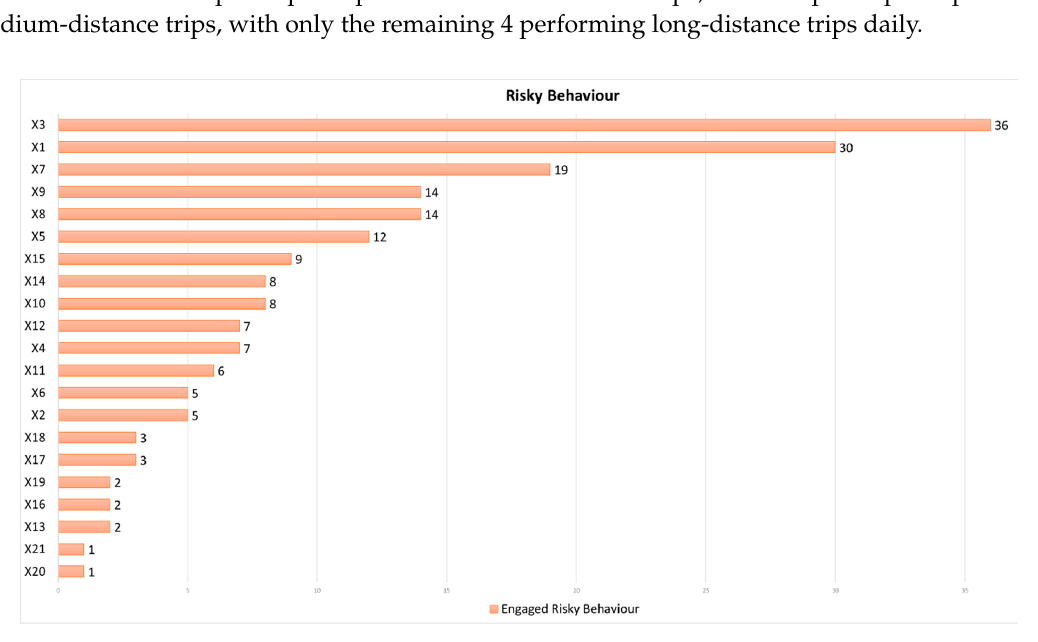
Figure 2. Self-report of most frequently engaged-in risky behavior.